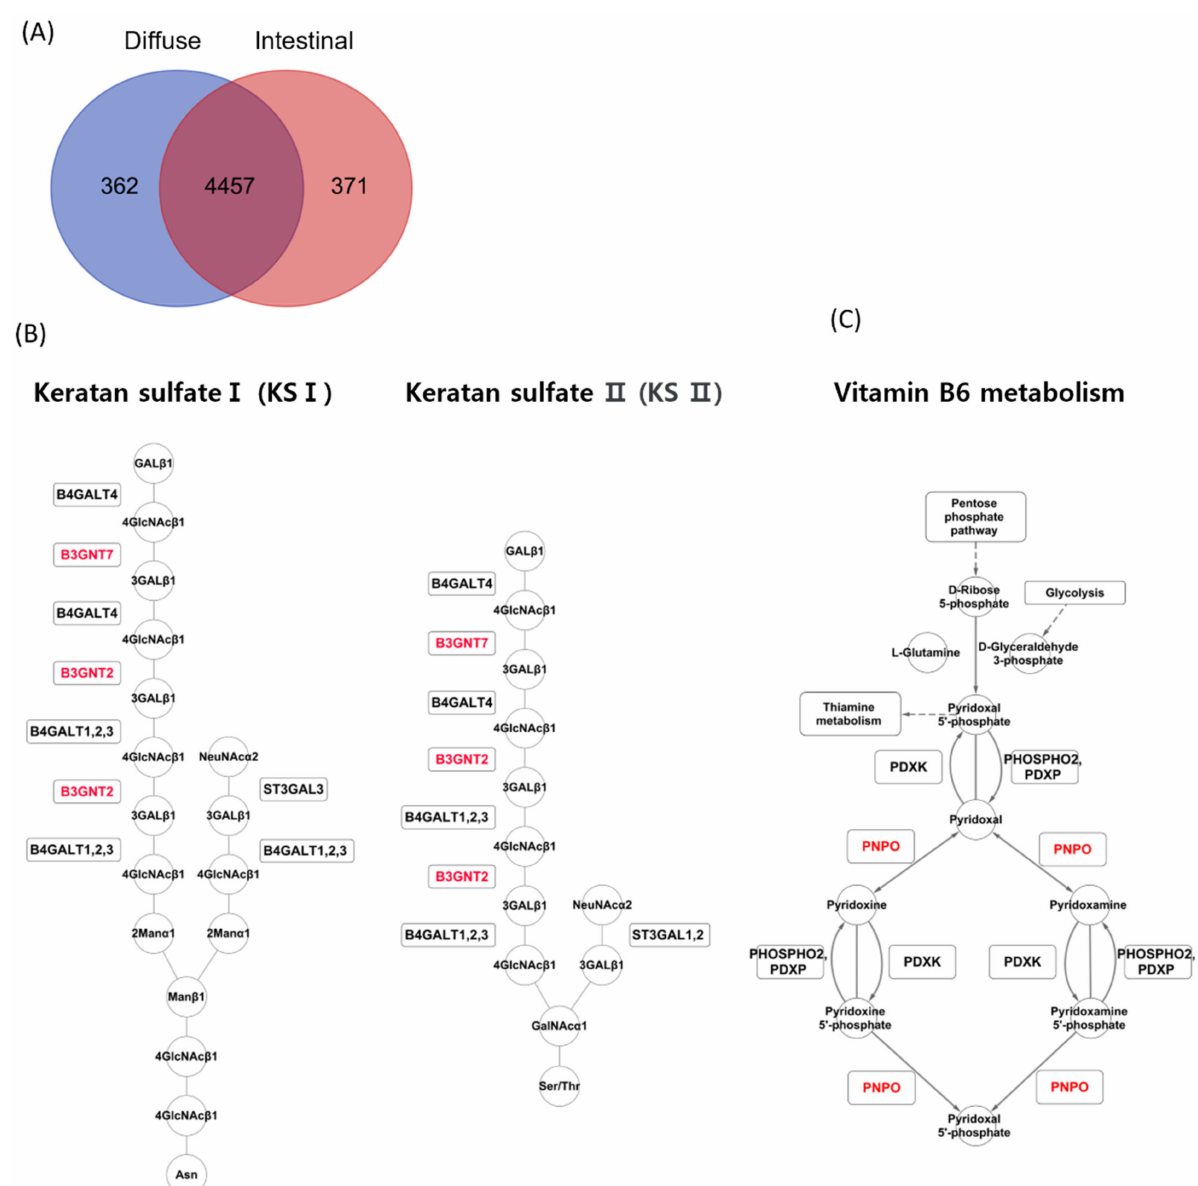
Figure 3. iMAT analysis for the two GC subtypes in the TCGA GC dataset. ( A ) Upregulated metabolic reactions in TCGA GC were obtained by iMAT for each subtype. ( B ) iMAT reported that B3GNT7 and B3GNT2 were involved in keratan sulfate synthesis in the diffuse subtype. ( C ) iMAT reported that PNPO was involved in vitamin B6 metabolism in the intestinal